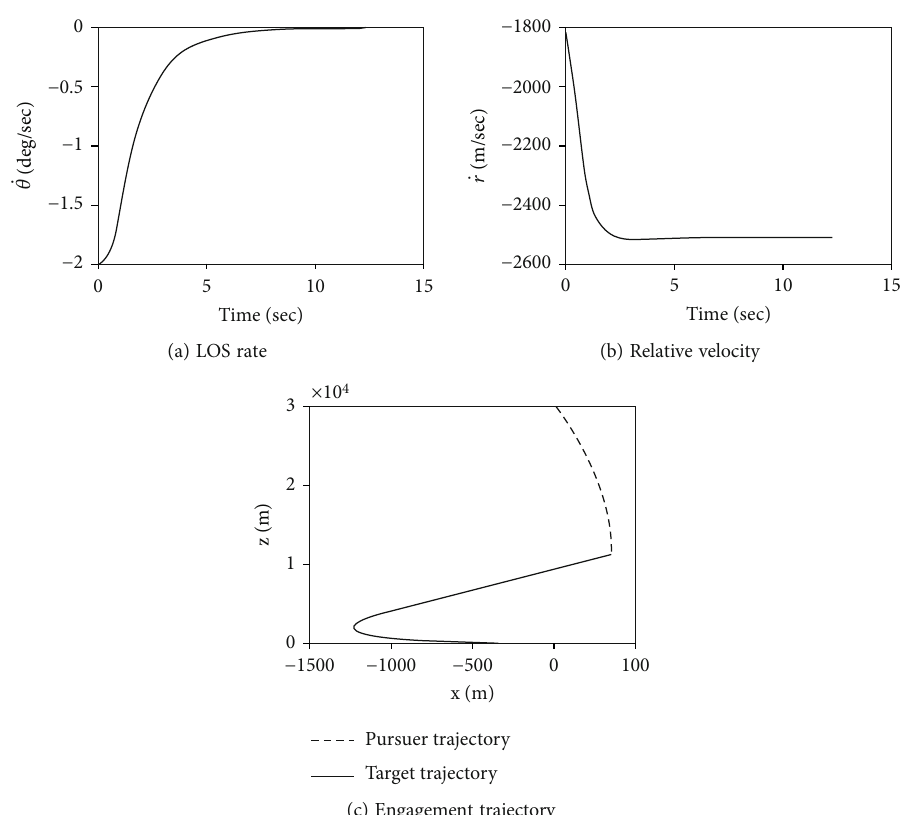
Figure 4: The engagement scenario against the step-maneuvering